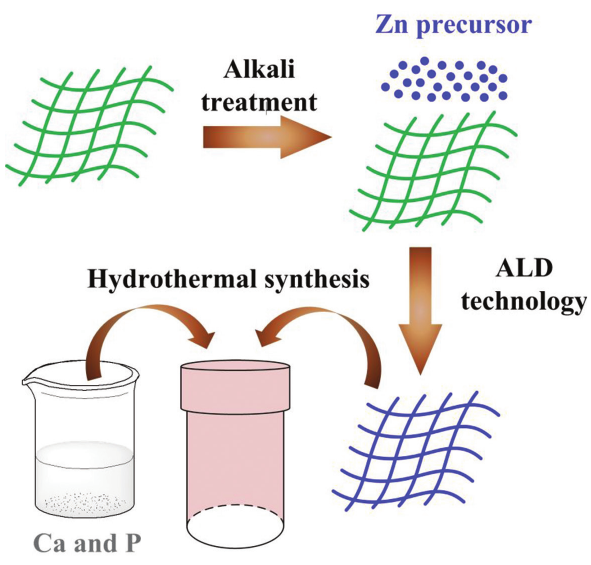
Figure 1: The procedure of the preparation of the ZnO/TTCP coated PET woven nets.